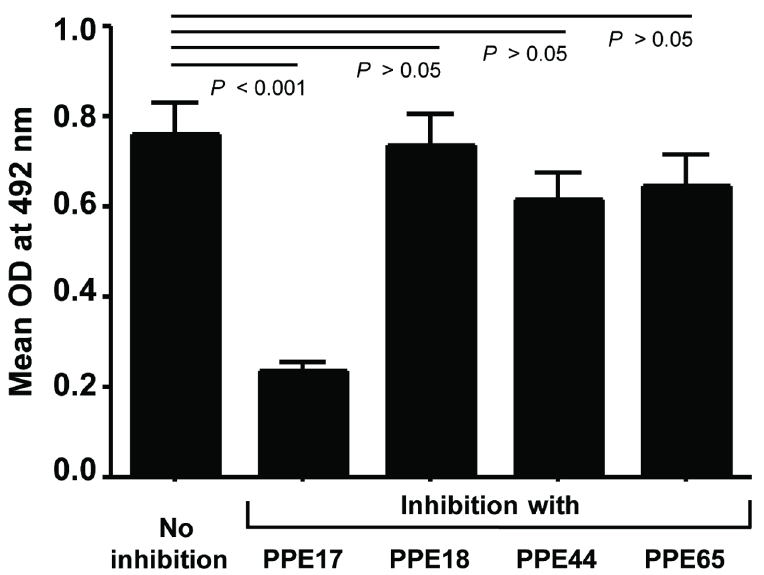
Fig 5. N-PPE17-specific antibodies in sera obtained from TB patients did not significantly cross-react with N-terminal domains of other PPE proteins. Sera samples (n = 50) pre-incubated with recombinantly purifiedfull-lengthPPE17 or PPE18 or PPE44 or PPE65 protein were added to EIA plates coated with recombinantly purified N-PPE17. The plates were further incubatedwith anti-humanIgG-HRP and absorbance was read at 492 nm using the chromogenic substrate